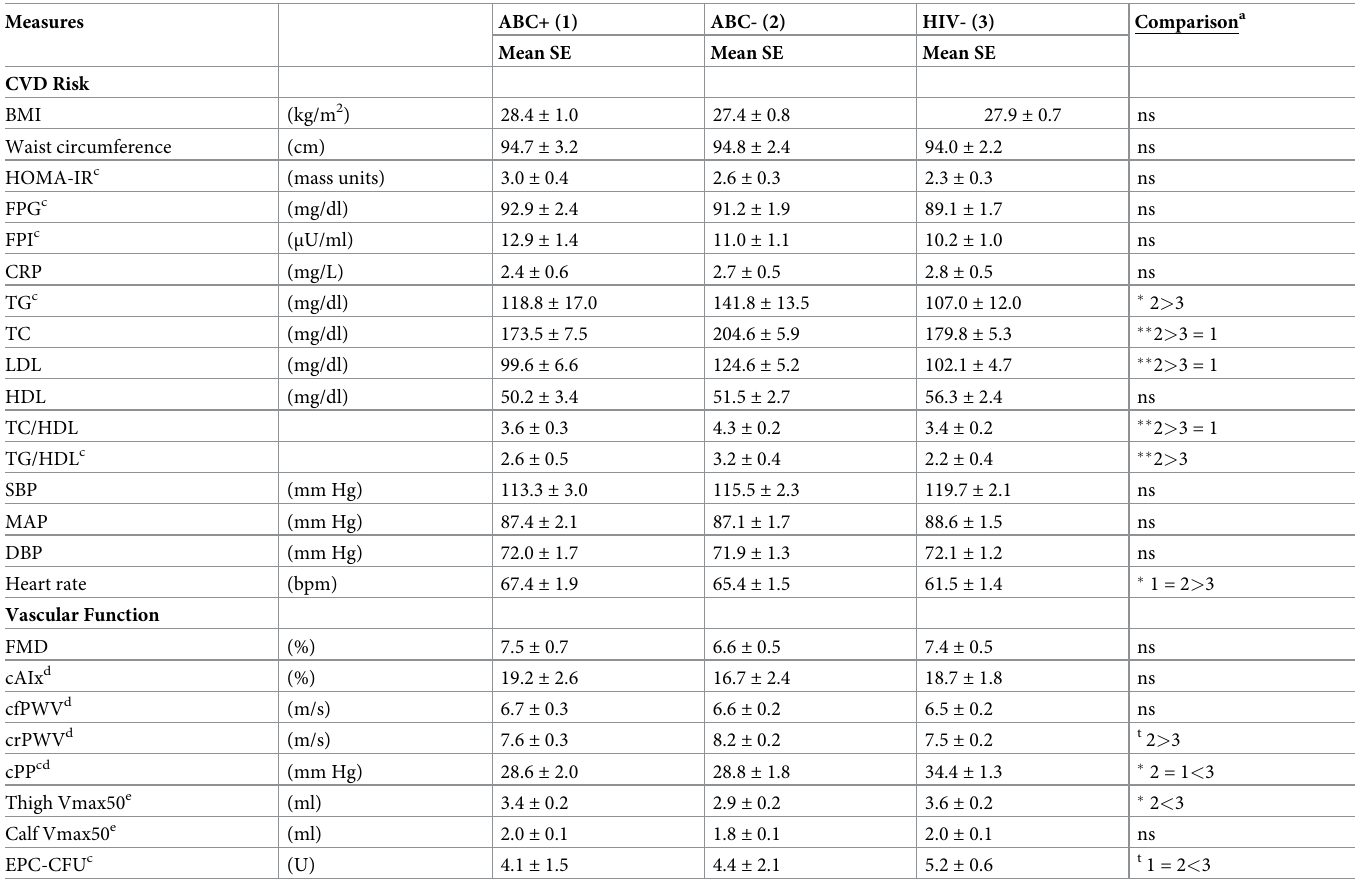
Table 6. Subclinical cardiometabolic measures comparing study groups when controlling for demographic variables (sex, age, education) and prescribed medica- tions (antihypertensive, statin-fibrate, antipsychotic, thyroid) and substance abuse score.